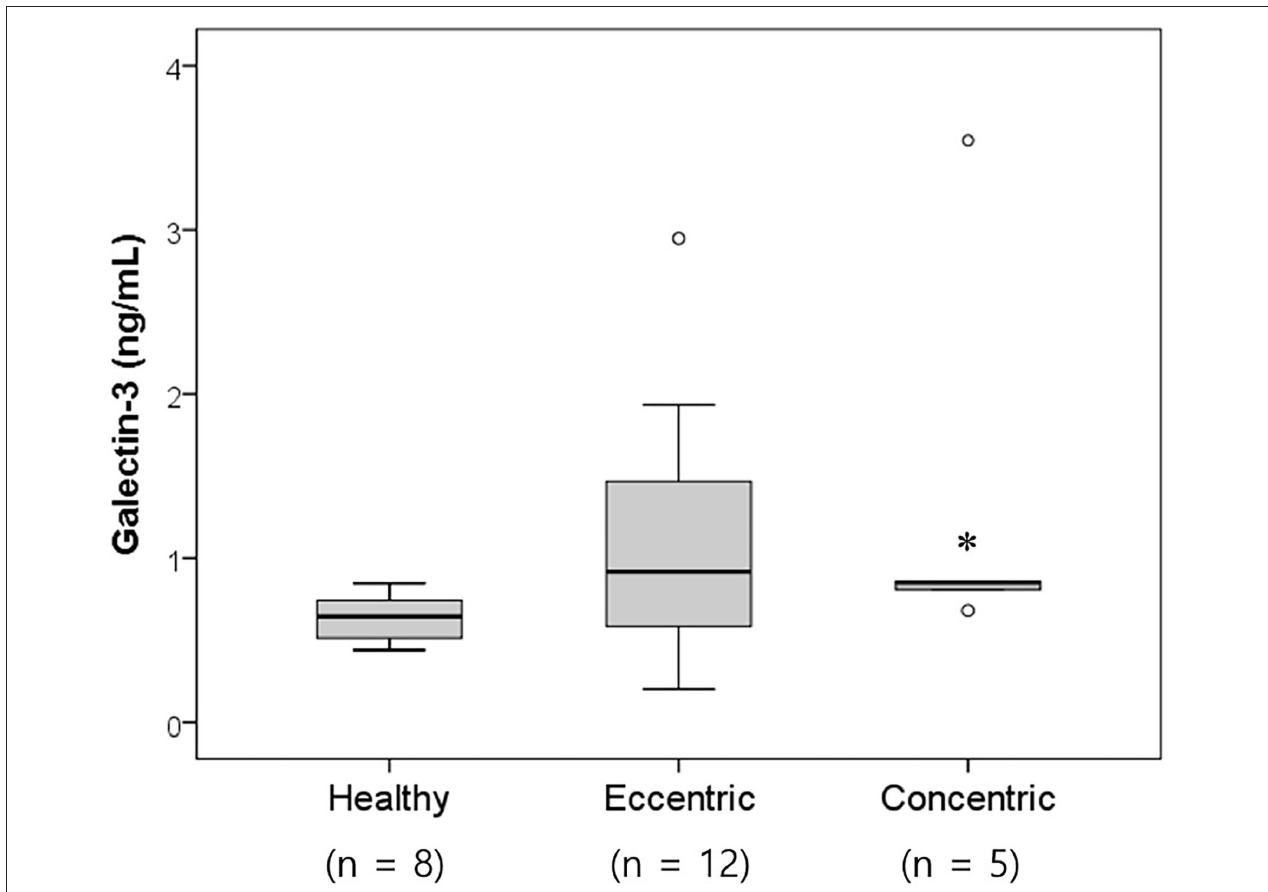
FIGURE 2 | Box and whisker plots of the galectin-3 levels in healthy dogs and dogs with heart diseases according to the cardiac hypertrophy type. The concentric cardiomyopathy group had significantly increased galectin-3 levels compared with the healthy group ( p = 0.028). Significantly different from the healthy group (* p <